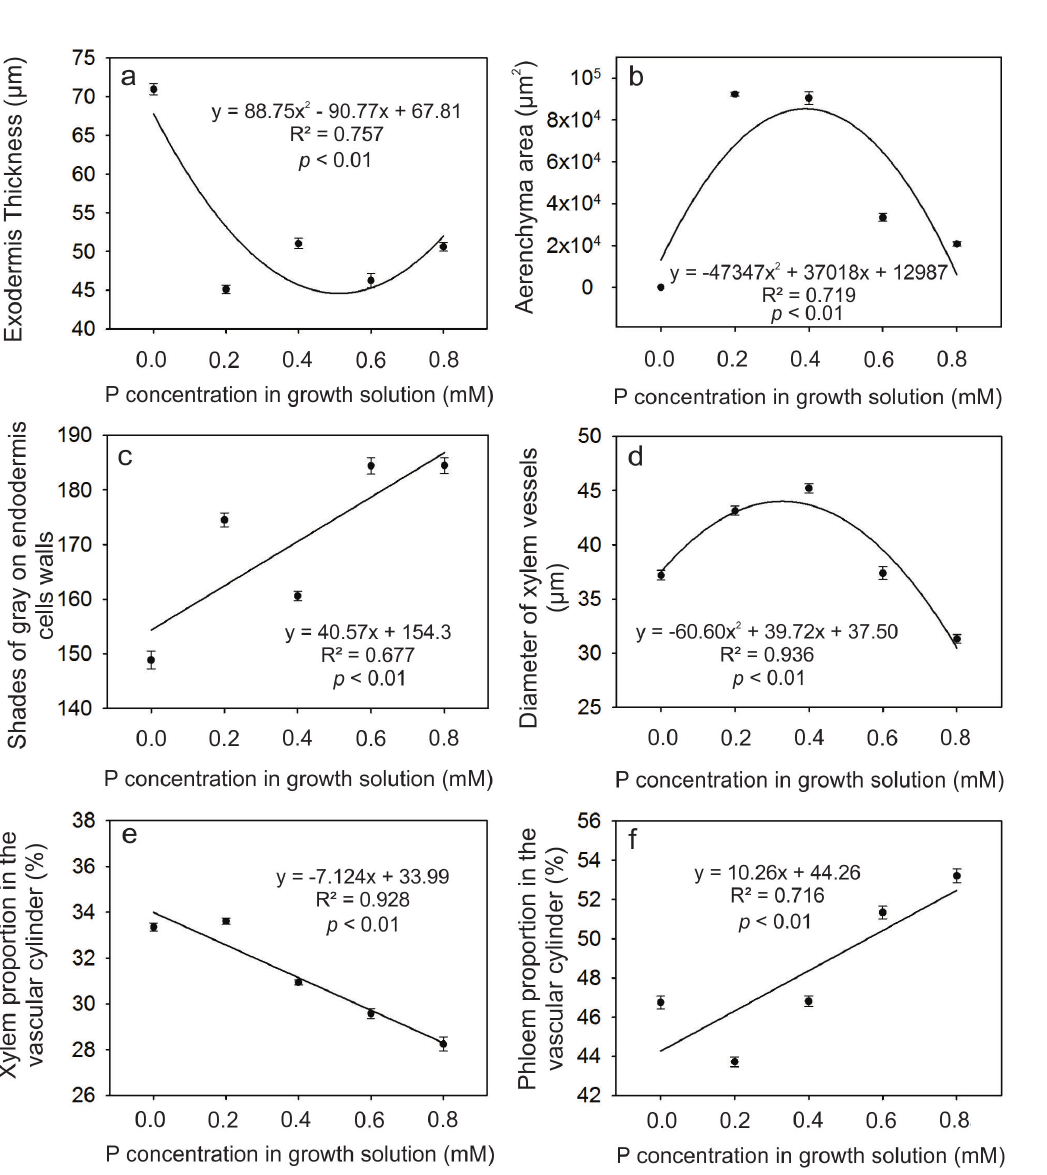
Figure 4. Micromorphometry of root tissues from T. domingensis plants grown under different phosphorus levels on the nutrient solution. Bars= standard